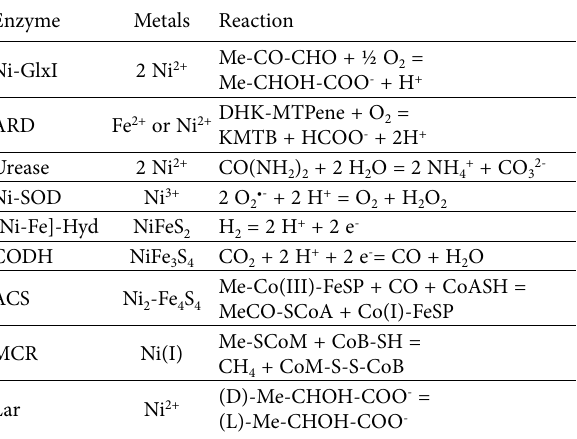
Table 2. The “two” most tightly bound nuclides in the universe, nickel (Ni) and iron (Fe), are at the heart of many crucial biological processes involving at least nine different Ni-based enzymes used by 80% of the archaea and 60% of the eubacteria. Glx = Glyoxalase, ARD = Acidreductase dioxygenase, SOD = Superoxide dismutase, Hyd = Hydrogenase, CODH = CO dehydrogenase, ACS = Acetyl- CoA synthase, MCR = Methyl-coenzymeM reductase, Lar = Lactate racemase, DHK-MTPene = 1,2-dihydroxy-3-keto-5-methylthiopen- tene, KMTB = 2-keto-4- methylthiobutyrate, FeSP = corrinoid/Fe–S